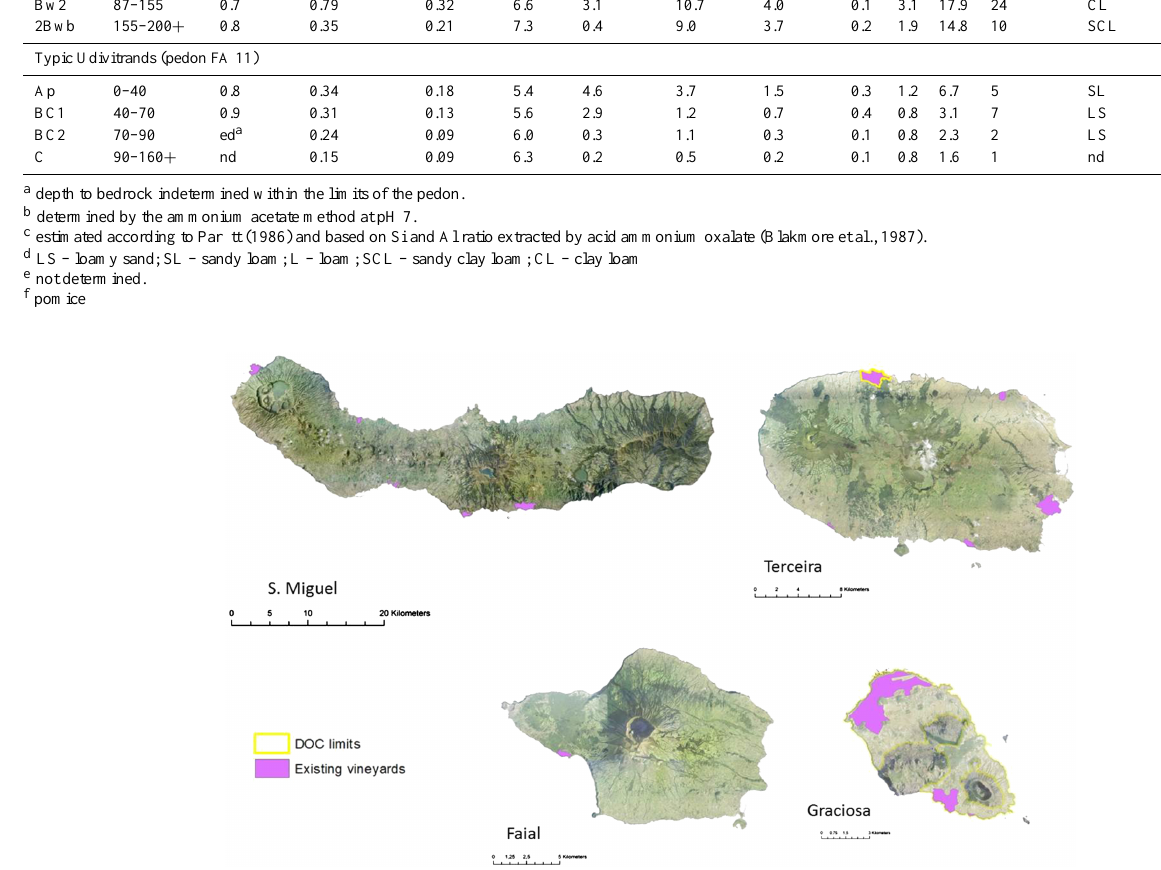
Figure 4. Distribution of the existing traditional vineyard areas and DOC limits in the Azores